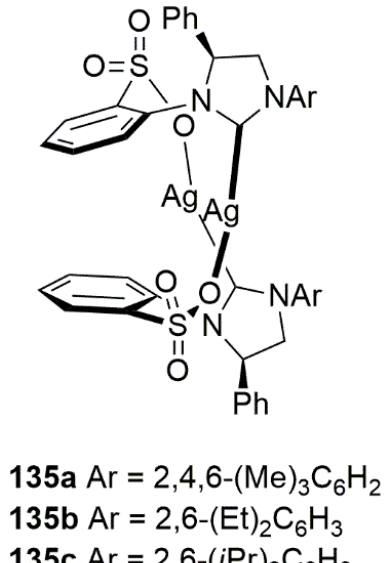
Figure 13. Dimeric silver complexes with NHC-sulfonate donors [90].